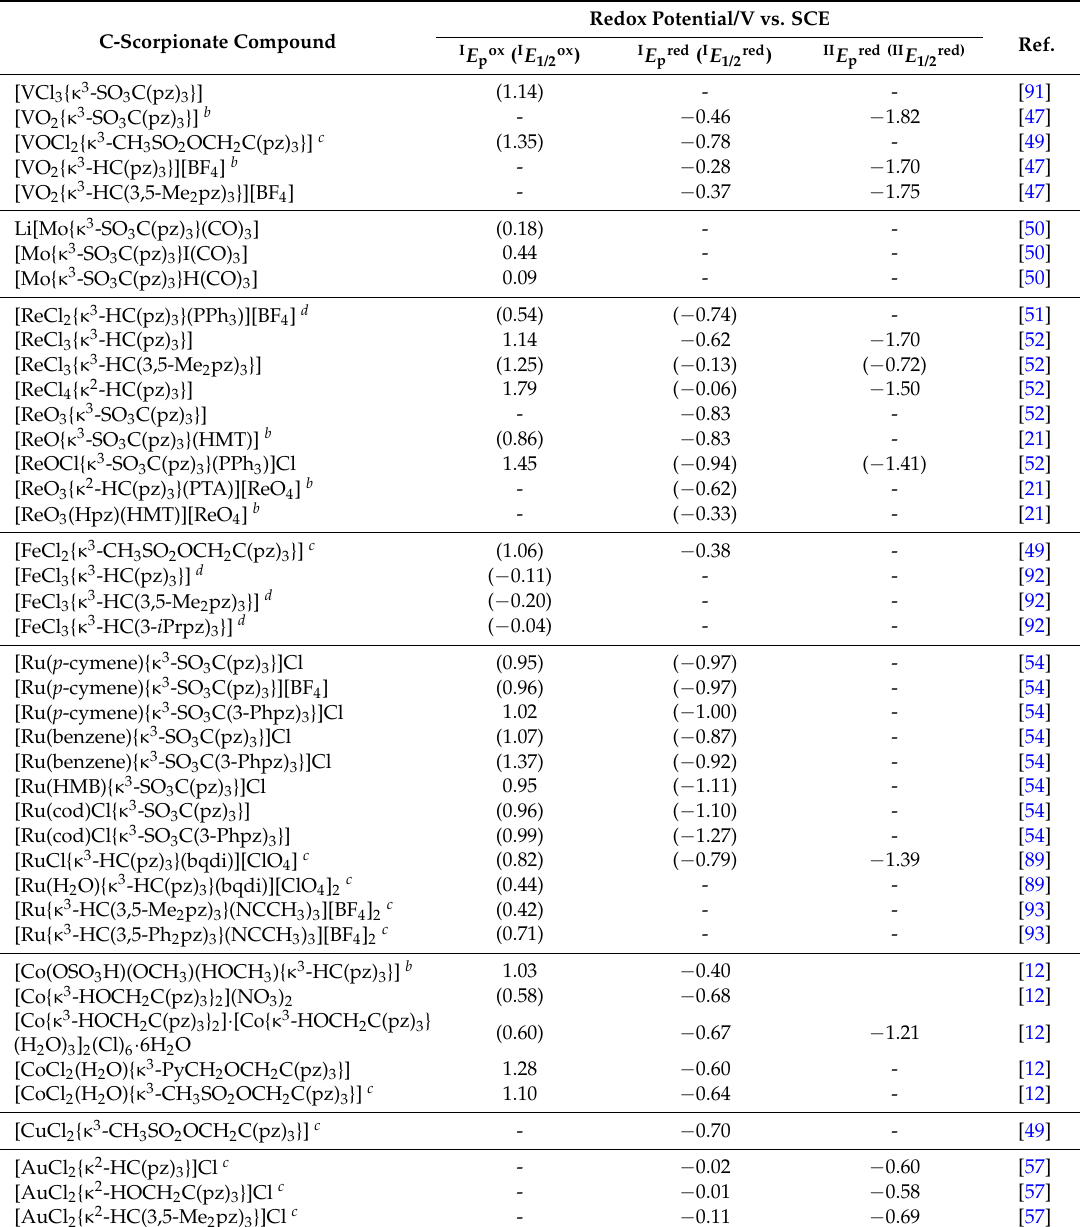
Table 1. Cyclic voltammetric data a for metal C-homoscorpionate complexes.